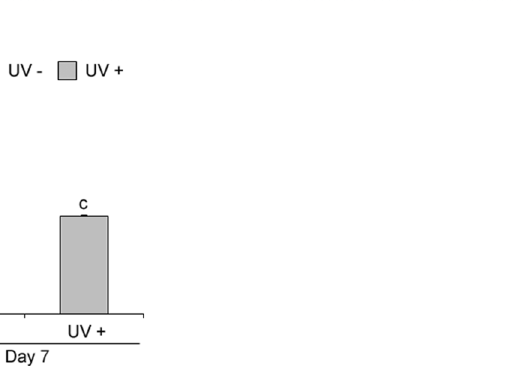
Figure 2. Effects of UVC on the expression of genes related to vitamin C metabolism. Acerola fruits without (UV−) or with UVC treatment (UV+), were stored at 10 °C for 0 day (Day 0) or 7 days (Day 7). Not detectable (ND), likely caused by oxidation of RNAs from the fruits. Data, obtained from triplicate repeats, are shown as mean ± SE values. Different letters indicate significant differences by the ANOVA/Tukey-HSD ( p < 0.05).